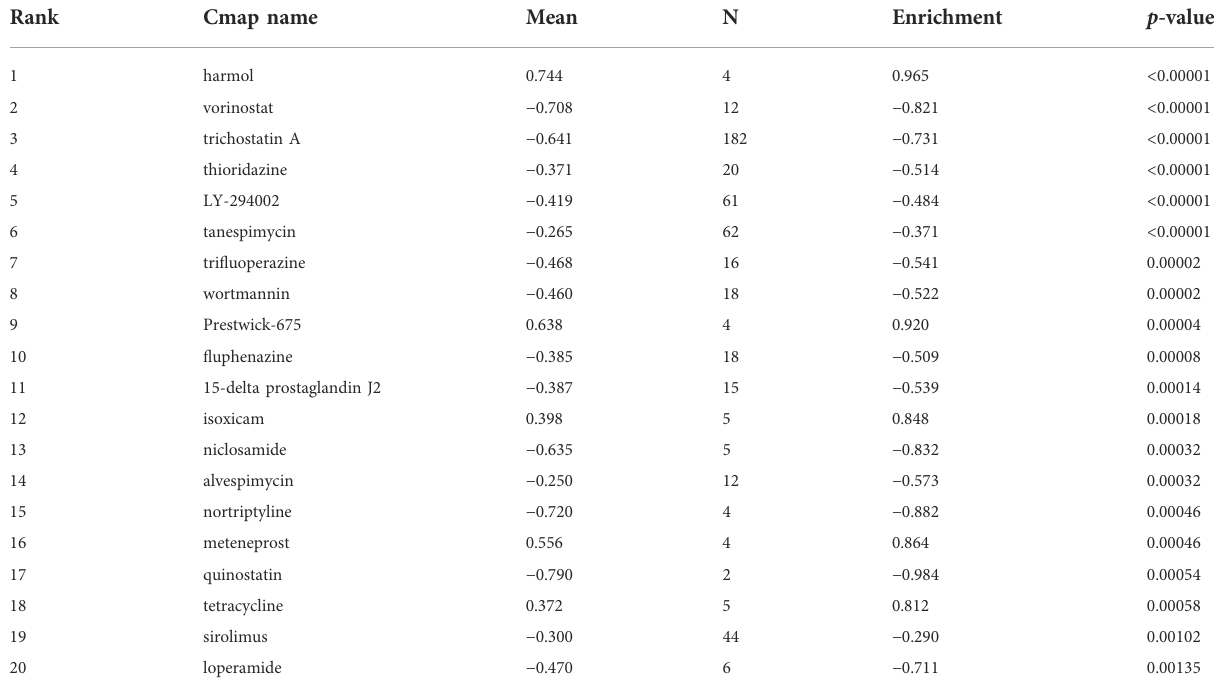
TABLE 3 Drugs in the Cmap